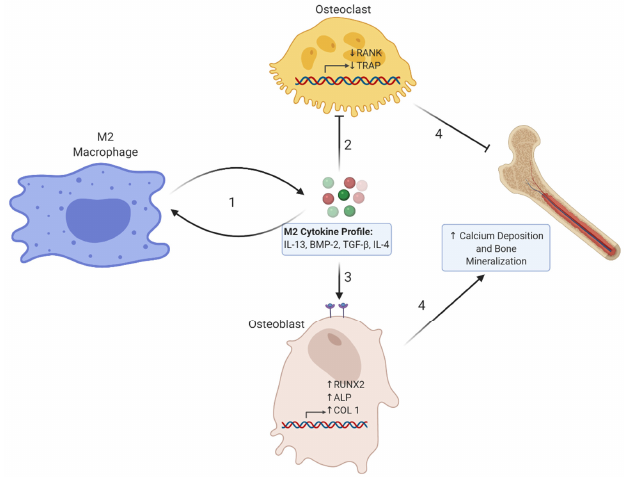
Figure 1. Schematic Diagram Showing the Relationship Between M2 Cytokine Profiles, Macrophage Phenotypes, and Osteoblast and Osteoclast Activity. 1 . M2 cytokines, which include interleukin-13 (IL-13), bone morphogenetic protein 2 (BMP2), transforming growth factor beta (TGF- β ), and interleukin-4 (IL-4), amongst others, participate in part of a feedback loop; They stimulate M2 macrophage polarization, which upregulates the production of M2 cytokines. 2 . M2 cytokine signaling on osteoclasts through their respective receptors downregulates osteoclastic genes, including receptor activator of nuclear factor kappa-B ligand (RANK) and tartrate resistant alkaline phosphatase (TRAP), which inhibits osteoclast di ff erentiation and activation. 3. M2 cytokine signaling on osteoblasts through their respective receptors upregulates osteogenic genes including Runt-related transcription factor 2 (RUNX2), alkaline phosphatase (ALP), and type 1 collagen (COL 1), which increases osteoblast di ff erentiation and activity. 4. The collective e ff ects of M2 cytokines on di ff erent cell types may lead to increased calcium deposition and bone